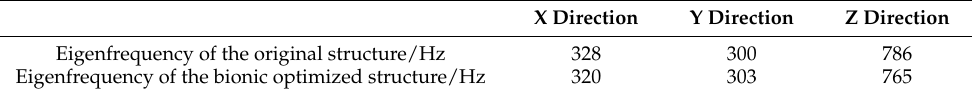
Table 3. Eigenfrequencies of the vertical bracket for experience and bionic optimization